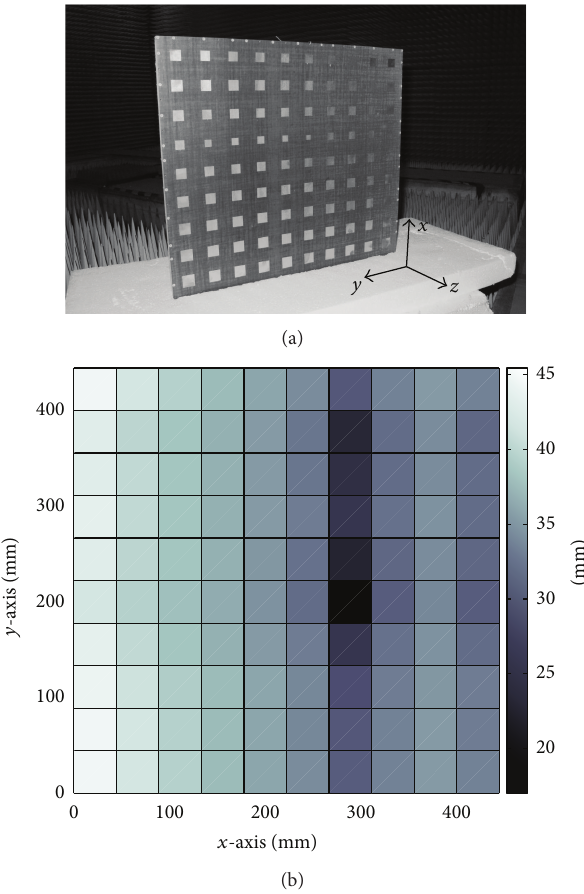
Figure5:(a)Photographofanonuniformsurfacesamplecomposed of three-layer stacked-patch elements. Note that the bottom row of elements is buried in foams and can not be seen. (b) Two- dimensional distribution of dimension 𝑑 for patches on the bottom layer (unit: